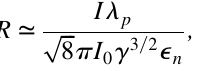
Fig. 7: Frame (a) mostly reflects the effect of charge yield